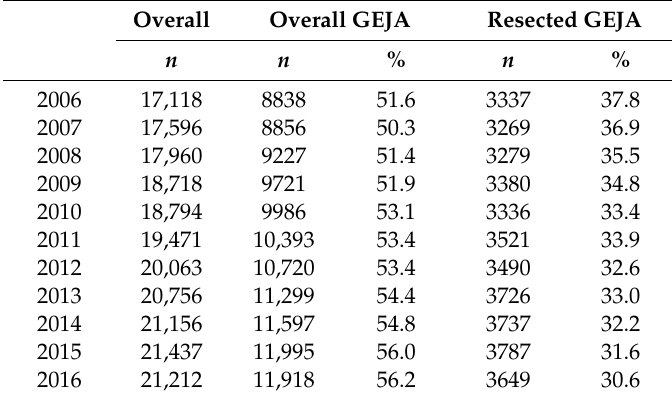
Table A1. Overall number of esophageal and gastric cases combined, overall number of Gastroesophageal Junction Adenocarcinoma (GEJA) cases, and rate of